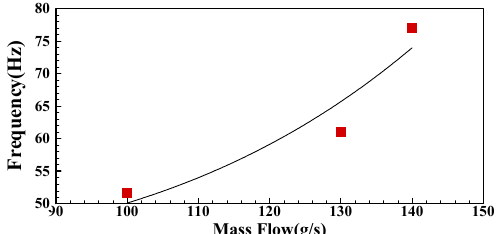
Figure 22. Variation of the secondary dominant frequency of cold DP under different inlet flows.